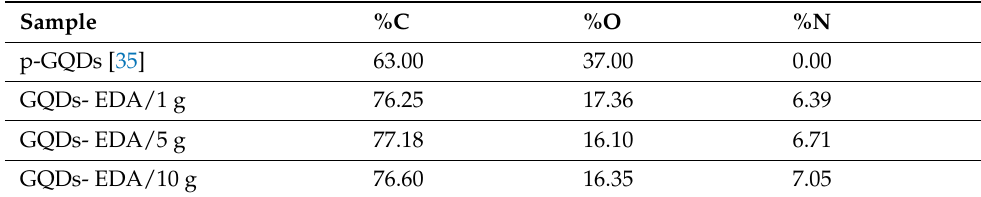
Figure 4. Analysis of high-resolution XPS spectra of C 1s region for samples GQDs-EDA/1 g ( a ), GQDs-EDA/5 g ( b ), and GQDs-EDA/10 g ( c ).